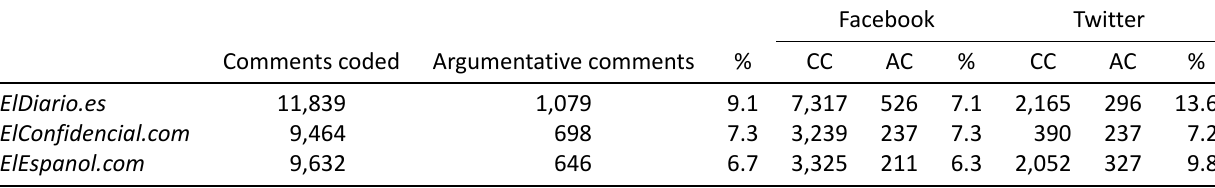
Table 6. Do users try to argue their point?